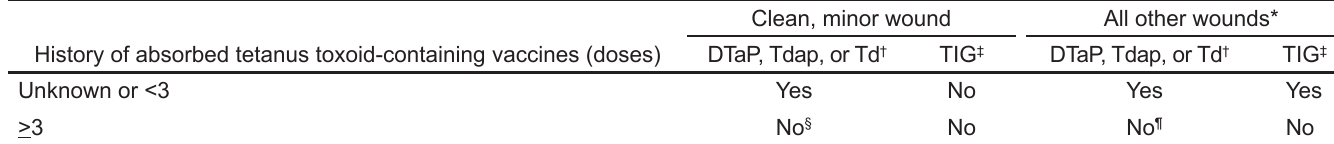
Table. Centers for Disease Control and Prevention guide to tetanus prophylaxis with tetanus immunoglobin in routine wound